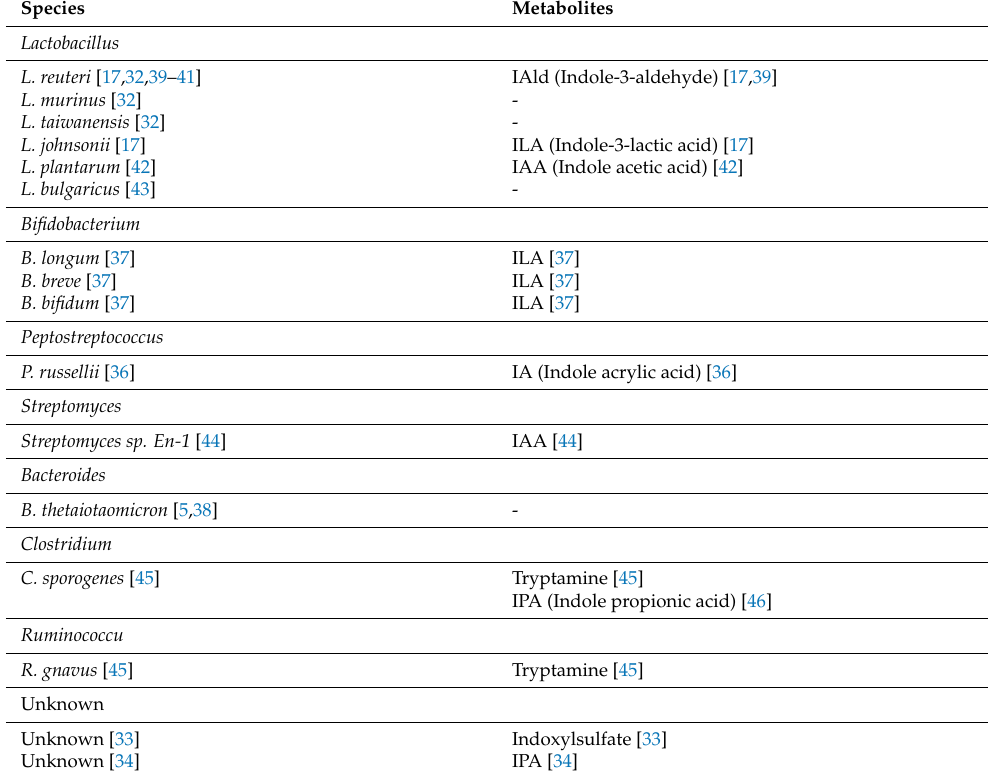
Table 1. AHR-activating-microbiota species.